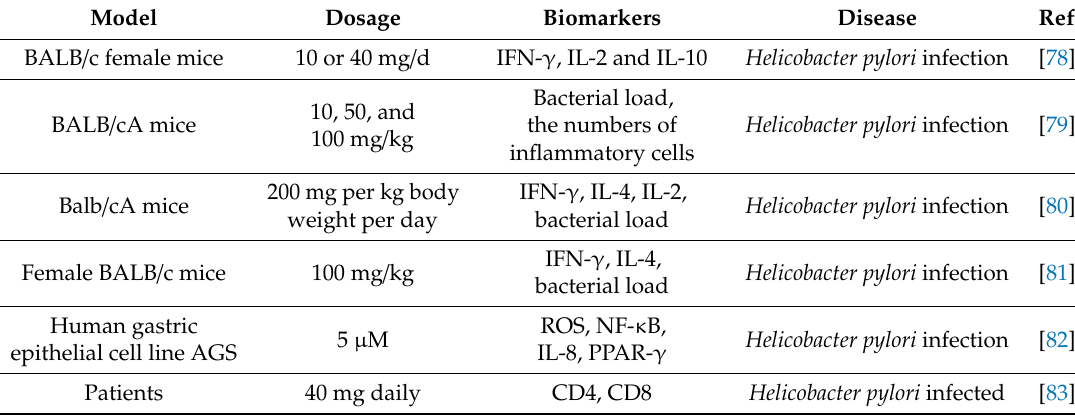
Table 5. The anti-inflammatory e ff ects of astaxanthin in infectious